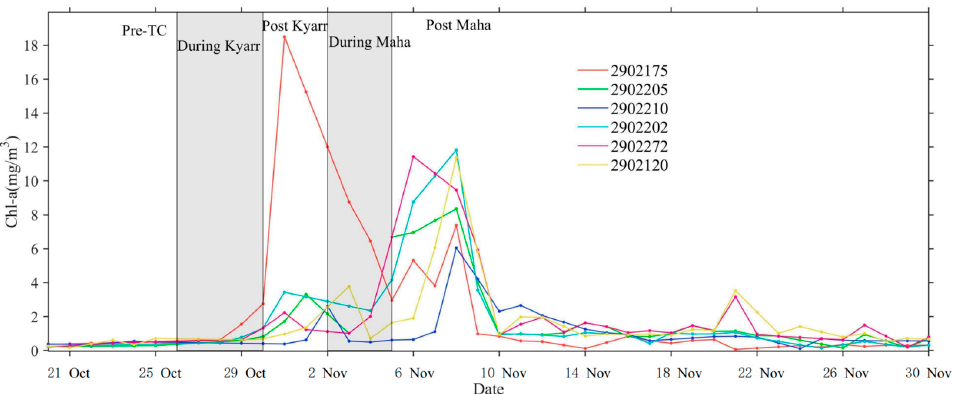
Figure 5. Two short periods of surface chl-a enhancement were derived from remote sensing